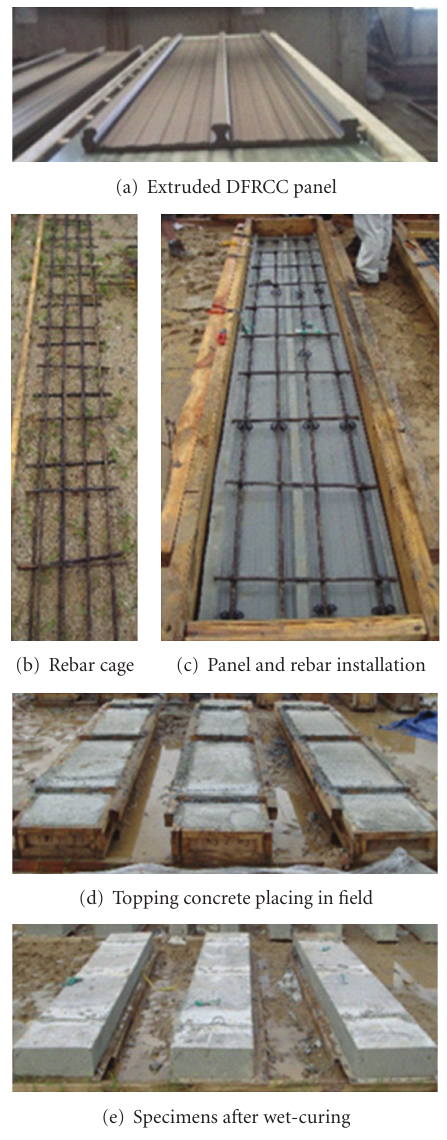
Figure 10: Manufacturing process of slab specimen.